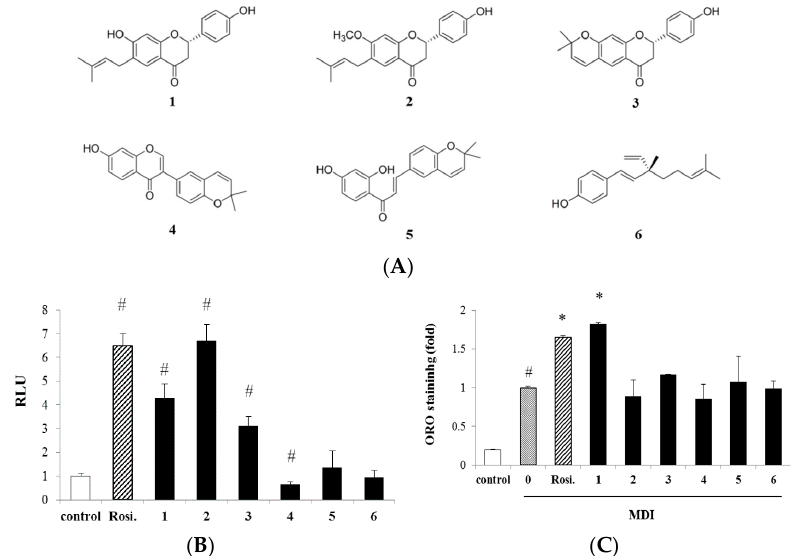
Figure 1. Effect of compounds on transactivation of peroxisome proliferator-activated receptor γ (PPAR γ ) and adipocytes differentiation: ( A ) Chemical structures of compounds 1 – 6 isolated from Psolarea corylifolia (PC); ( B ) Effect of compounds on transactivation of PPAR γ . CV-1 cells were transiently transfected with plasmid mixture containing PPAR γ expression vector and thymidine kinase-PPAR response element-luciferase (tk-PPRE-Luc) vector, and then treated with compounds (10 µ M). Data are presented as relative luciferase activity (RLU) divided by the β -galactosidase activity; ( C ) Effect of compounds on adipocyte differentiation. 3T3-L1 cells were differentiated in the presence of compounds 1 – 6 (2 µ M) or rosiglitazone (1 µ M). At differentiation Day 8 (D8), cells were stained with Oil Red O (ORO), and lipid accumulation was quantified by measuring absorbance. Data are expressed as mean ˘ standard deviation (SD). Control, media control; 0, MDI (the mixture of isobutyl-methylxanthine, dexamethasone, and insulin); Rosi., rosiglitazone; 1 – 6 , compounds 1 – 6 . # p < 0.001 vs. control; * p < 0.01 vs.